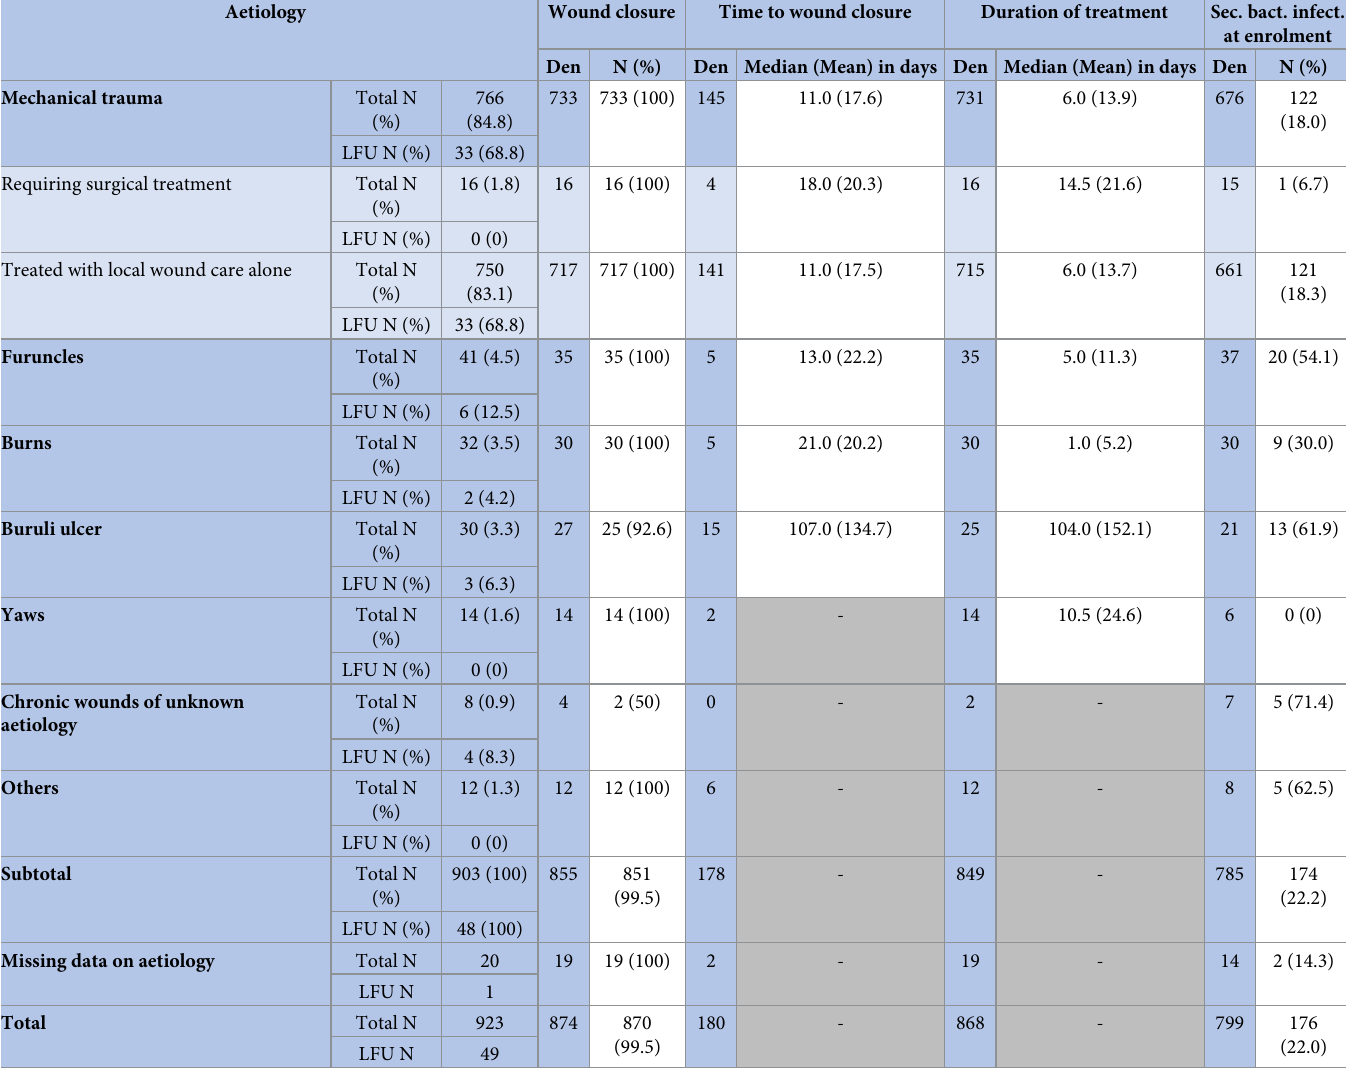
Table 1. Study endpoints for wounds stratified by main aetiology (confirmed